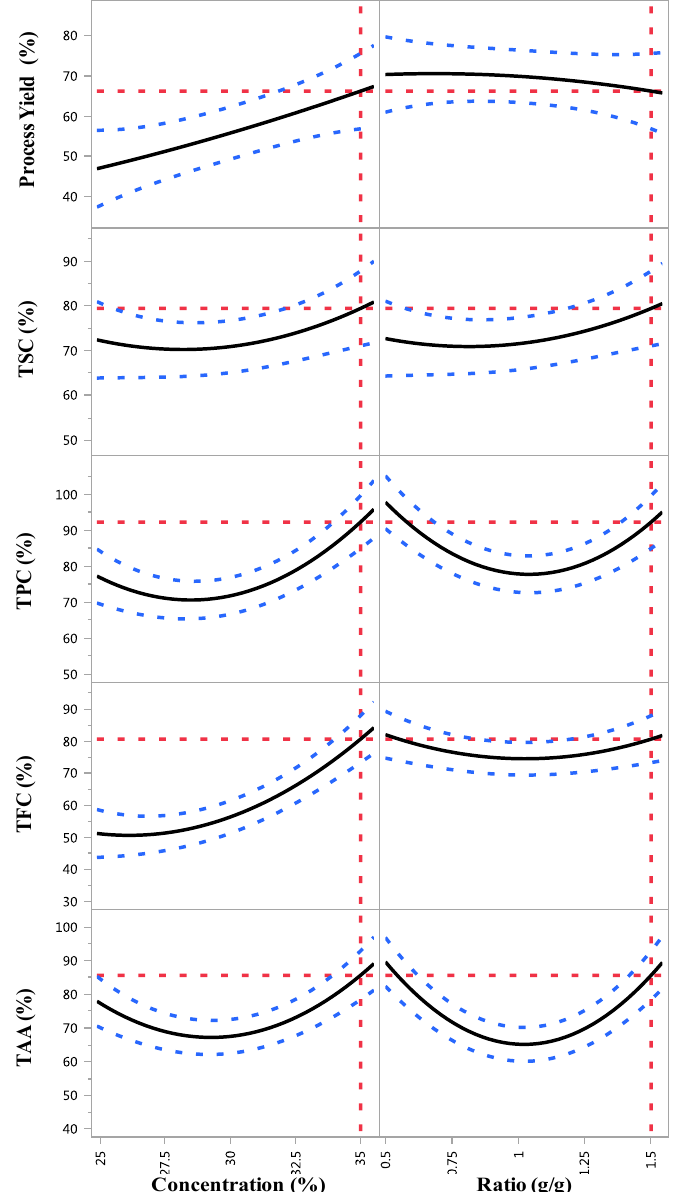
Figure 3. Prediction profiler plots for the process yield and the retentions of the process yield and the retentions of total saponin content (TSC), total phenolic content (TPC), total flavonoid content (TFC) and total antioxidant activity (TAA) of the encapsulated powder affected by concentration (X 1 ) and ratio (X 2